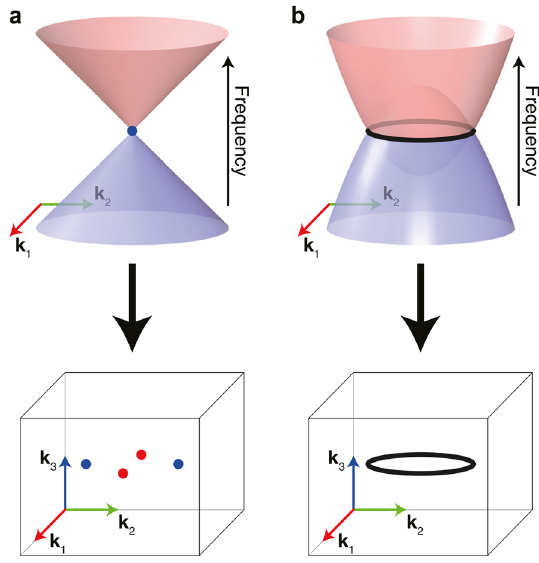
Figure 1: Schematics of band degeneracies. (a) and (b) correspond to a Weyl point and a nodal line,